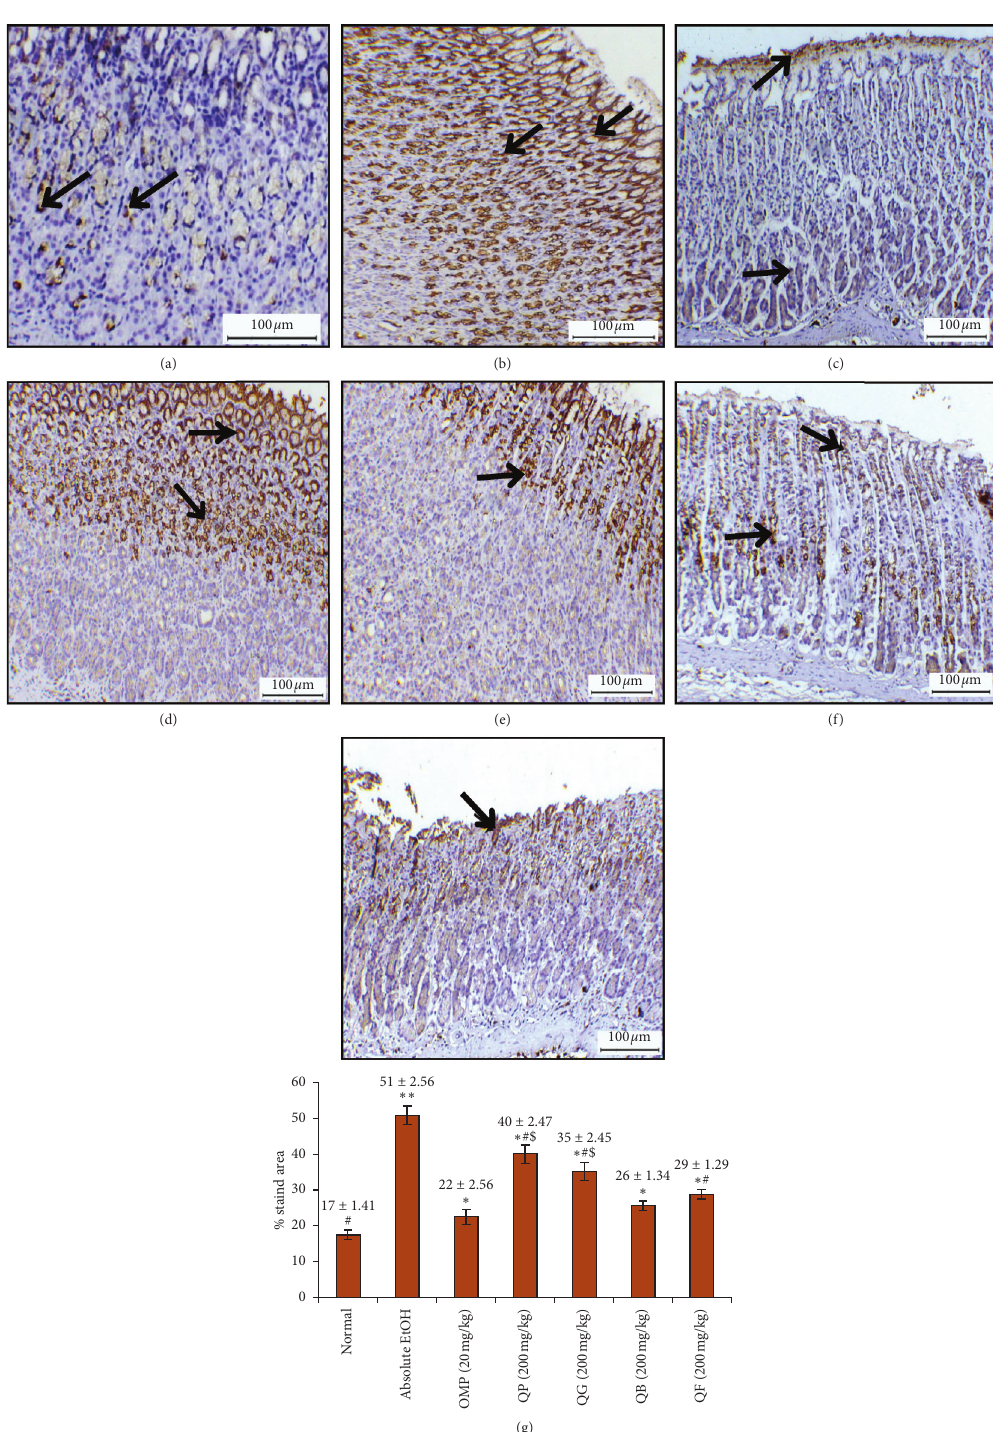
Figure 6: Effect of QP, QG, QB, and QF on the immunostaining of cyclooxygenase 2 (COX-2) enzyme in stomach sections from all animal groups. (a) Slight expression of COX-2 in normal stomach. (b) Marked overexpression of COX-2 in the gastric mucosa with intensive brown staining towards the upper part of stomach treated with absolute EtOH at dose of 5mL/kg (black arrow). (c) Slightly expressed COX-2 in the lower part of the gastric mucosa with fine brown-stained layer and COX-2 expression on the mucosal surface from the stomach treated with omeprazole (20mg/kg). (d) Moderately immunoexpressed COX-2 in the upper half of the mucosal part from the stomach treated with QP (quinoa seeds cooked under high pressure, 200mg/kg). (e) Stomach treated with QG (first stage-germinated quinoa seeds, 200mg/kg) showing mild expression of COX-2 in the top quarter of the gastric mucosa. (f) Stomach treated with QB (quinoa seeds fermented by Lactobacillus plantarum bacteria, 200mg/kg) showing considerable reduction in immuno-COX-2 expression in the upper part compared to the lower part of the gastric mucosa. (g) Stomach treated with QF (quinoa seeds fermented by Rhizopus oligosporus fungus, 200mg/kg) showing more expression of COX-2 in the upper part of the gastric mucosa than the lower part. Quantitative estimation of immunohistochemical staining based on the determination of the % positive-stained area analyzed from 6 images/group using ImageJ analysis software is charted down the images. ∗∗ p < 0 . 05 compared to normal. ∗ p < 0 . 05 compared to absolute EtOH. # p < 0 . 05 compared to omeprazole OMP. $ p < 0 . 05 compared to